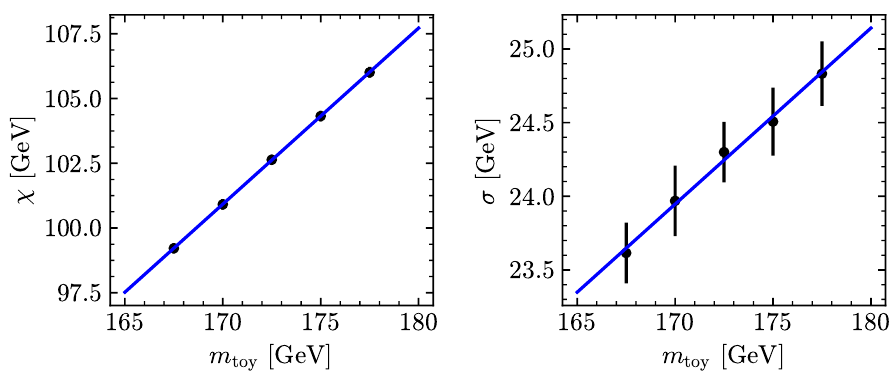
Figure 5 . The results of a test using the toy model, where the parametric (cid:12)tting function was assumed to be a Gaussian alone, which does not provide a good (cid:12)t to the underlying O distribution. The left and right panels show the mean and standard deviations of the template Gaussian for di(cid:11)erent values of m toy along with the linear (cid:12)t used to generate the template. The data points and error bars come from the average and standard deviation of 100 (cid:12)ttings of random samples.